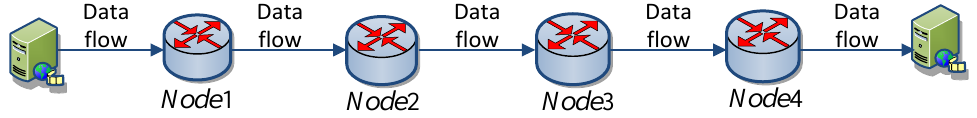
Figure 3 . A virtual channel оf cоmputer